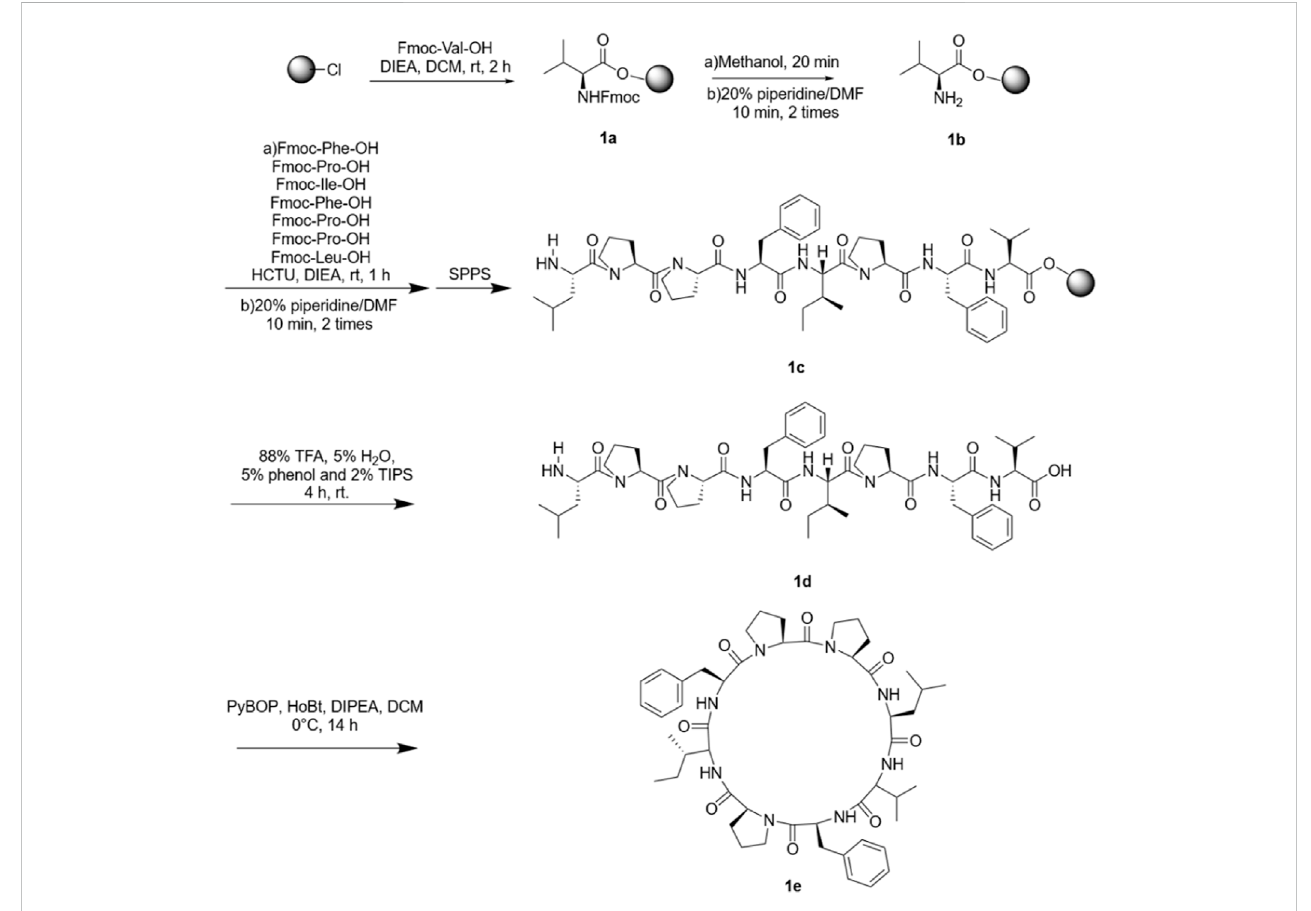
FIGURE 3 Synthesis route of